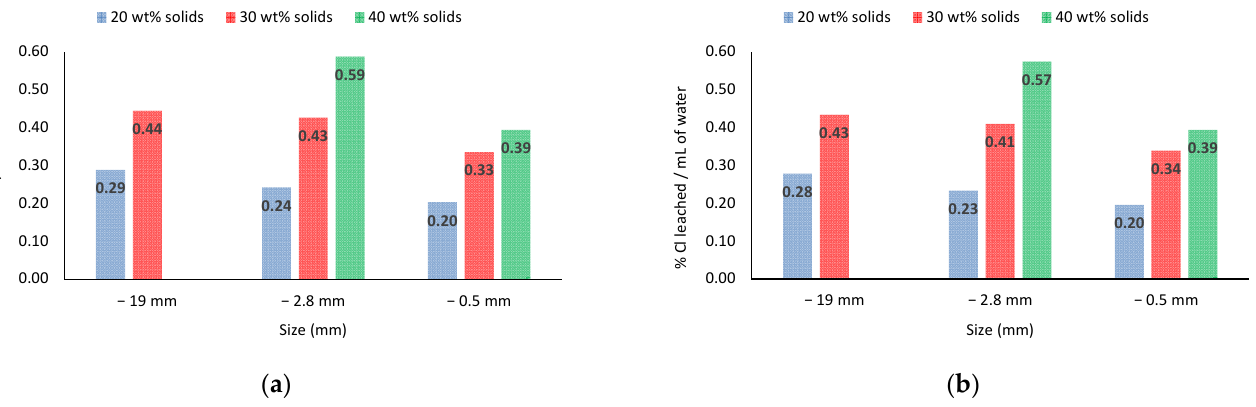
Figure 7. Cl − leached per volume of water used. ( a ) Distilled water system; ( b ) Tap water system.